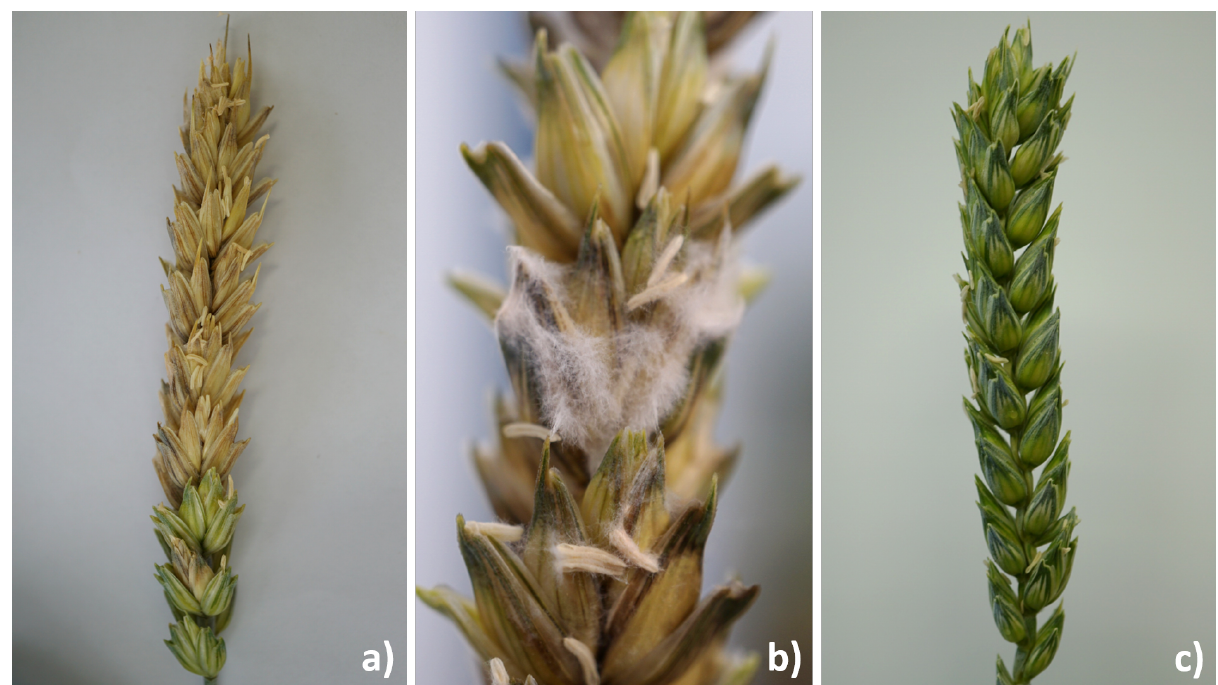
Figure 2. Wheat-ears symptom expression in a climate chamber experiment after 14 days of infestation: ( a ) distinct FHB disease symptoms on the ear; ( b ) fungal mycelium on the ears is visible; ( c ) symptom-free control wheat-ear (only treated with 1/4strength Ringer’s solution).